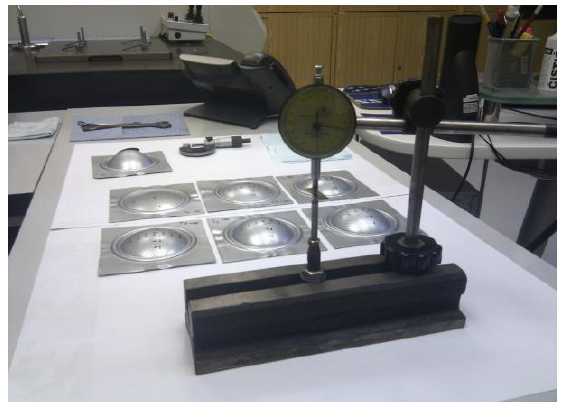
Figure 3. Measuring the thickness of a specimen after the bulge